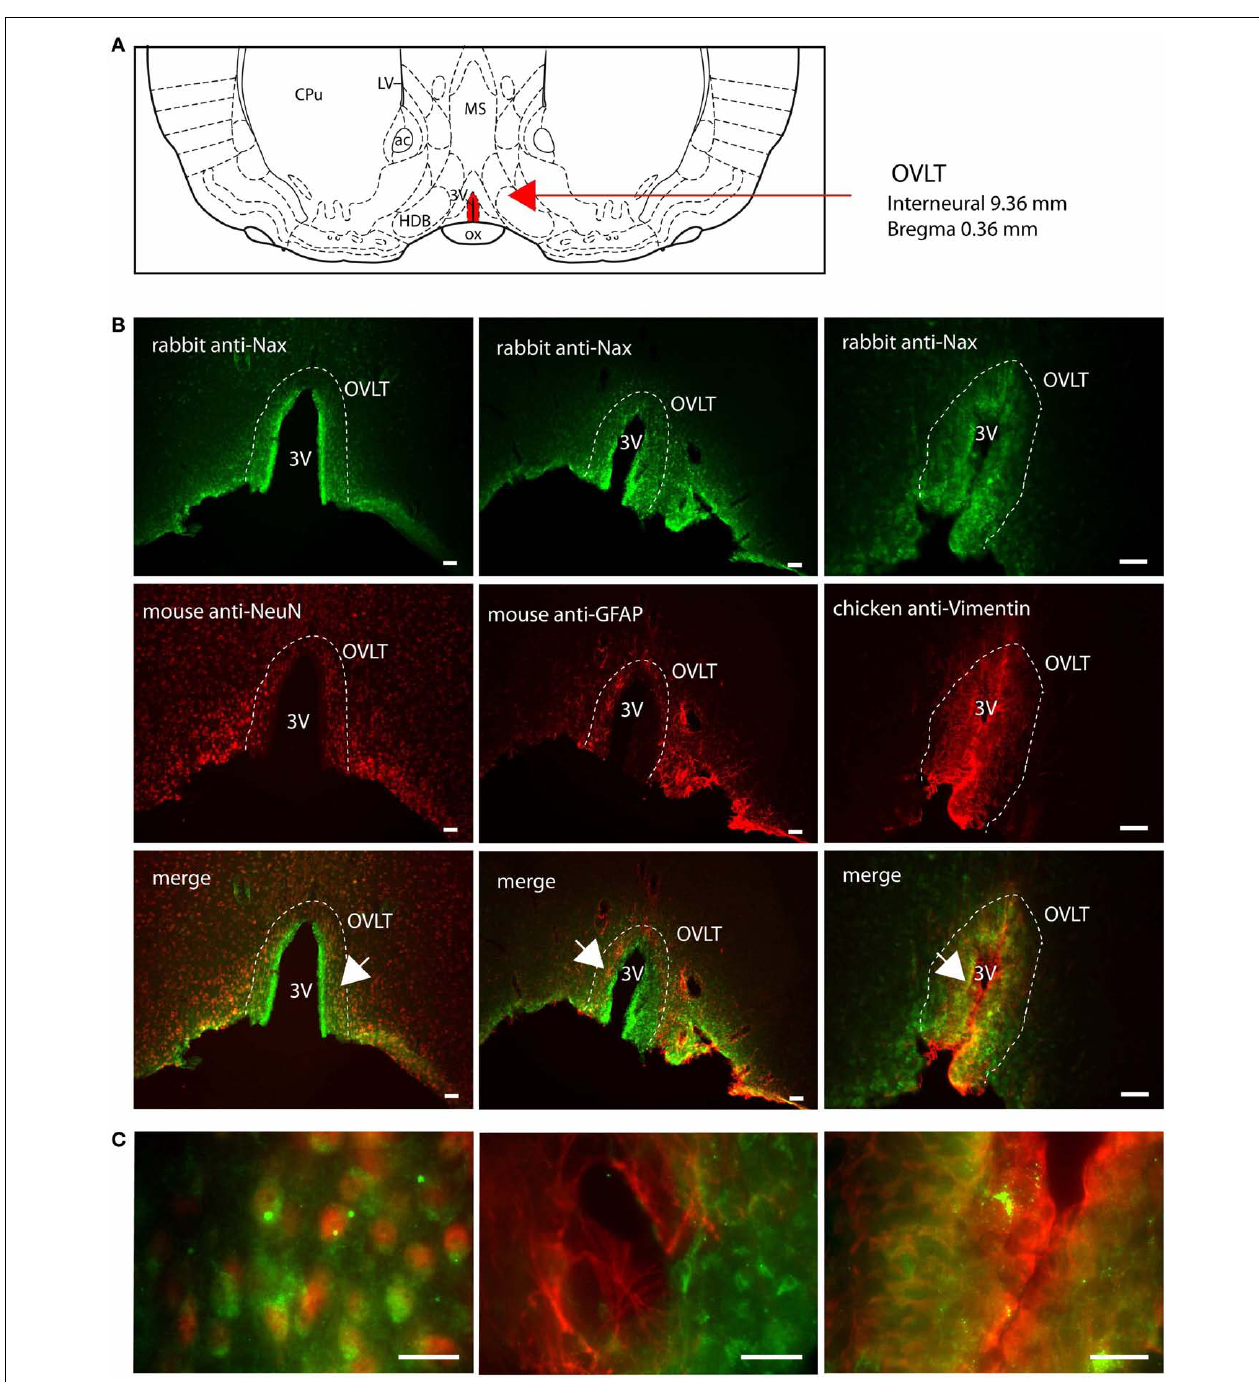
obtained from the rat.The OVLT region is delimited by the dashed line. 3V, third ventricle.The cell type expressing Na X was identified using anti-NeuN, anti-GFAP, and anti-vimentin fluorescent immunostaining (red); scale bar: 100 µ m. (C) High magnification pictures of the staining merge; scale bar: 20 µ m.The arrow head points the top-right corner (left panel) or the top-left corner (middle and right panel) of the enlarged area. Note that Na X staining is present in NeuN expressing cells and in vimentin positive